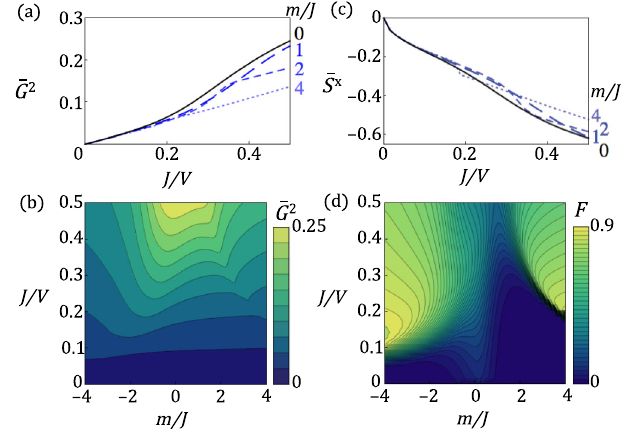
FIG. 5. Validity of the microscopic model. (a) and (b) Gauge P G 2 =N , is only violated sub- invariance, quantified by (cid:1) G 2 (cid:7) m i i stantially when V=J is not a strong energy scale. (c) At large J=V ¼ KB=V 2 , the gauge fields acquire a finite (cid:1) S x (cid:7) P S x =N . The detrimental effects encountered in panels m i i;i þ 1 (a)–(c) are enhanced around m ¼ 0 , i.e., close to the quantum phase transition of the QLM. Curves in panels (a) and (c) are for m=J (cid:4) 0 , as given in the figures. The behavior for m=J < 0 is ð m; J Þi be- very similar. (d) The overlap F ¼ h c ð m; J; V Þj c ideal tween the ground states of the microscopic model and the ideal QLM, Eq. (13), is largest at intermediate J=V and increases with increasing j m=J j